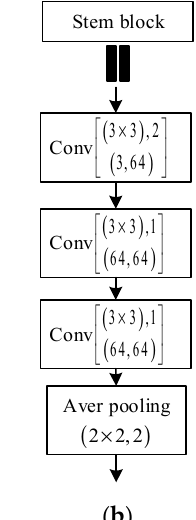
Figure 5. The construction of the D-layer.